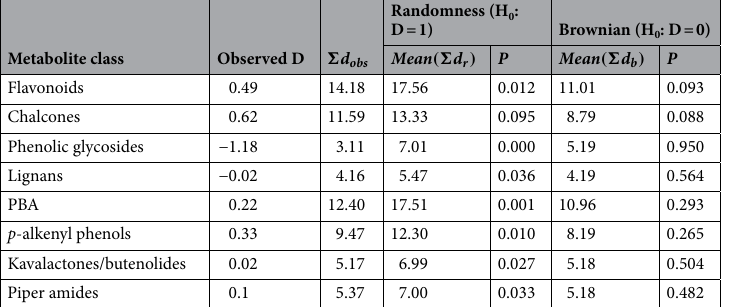
Table 1. Estimates of phylogenetic signal (D) 57 for a subset of metabolite classes (see “Methods” for explanation of subset). To ask whether traits evolved under scenarios of Brownian motion (D = 0) or phylogenetic randomness (D = 1), observed values of D were compared to null distributions of D modeled under each scenario.